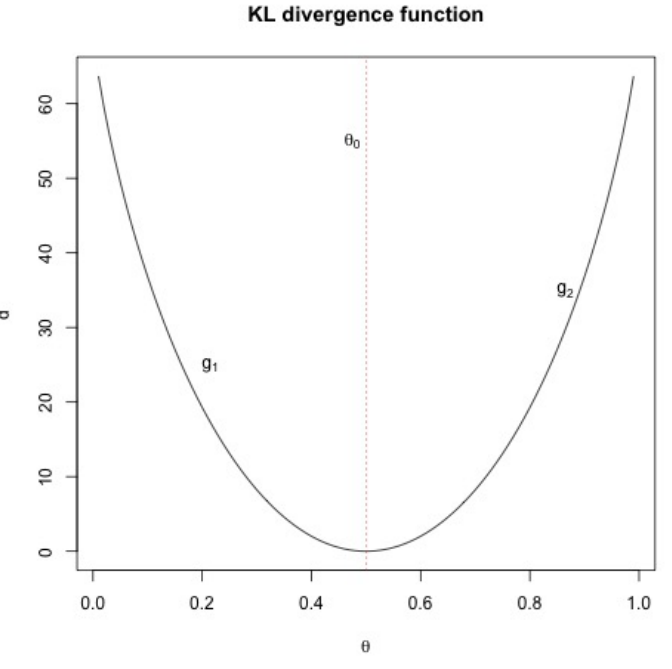
Figure 1. Plot of d = g ( θ ) , the KL divergence function in (7). In the plot, we set θ 0 = 0.5 and n =